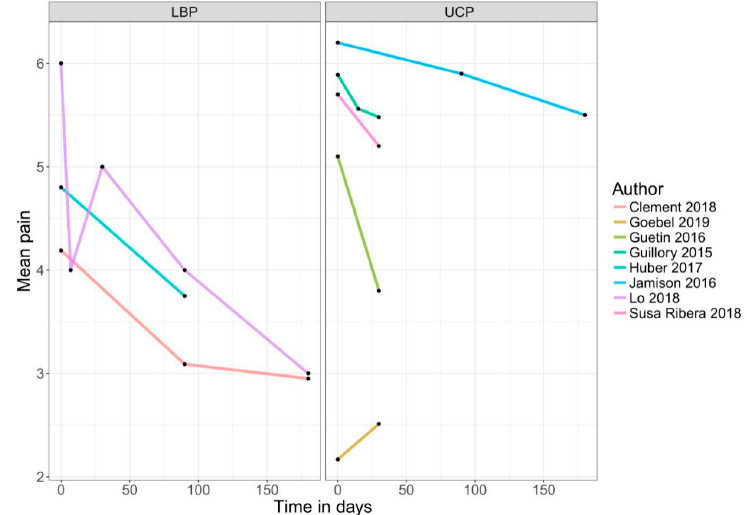
Figure 4. Improvement in pain over time in pre–post studies. Abbreviations: LBP = low back pain; UCP = unspecific chronic pain.